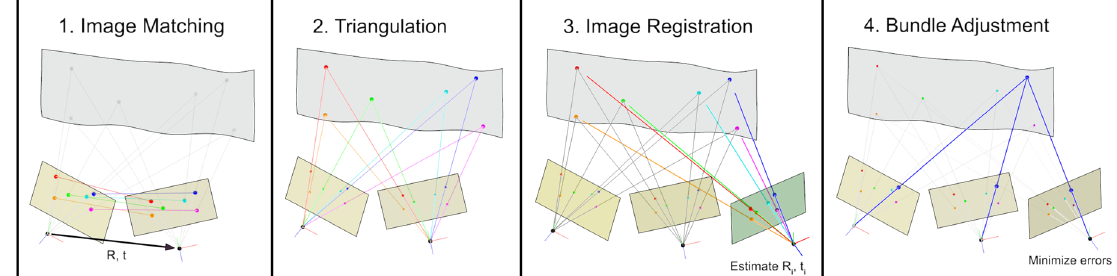
Figure 9. Visualization of the structure from motion procedure.